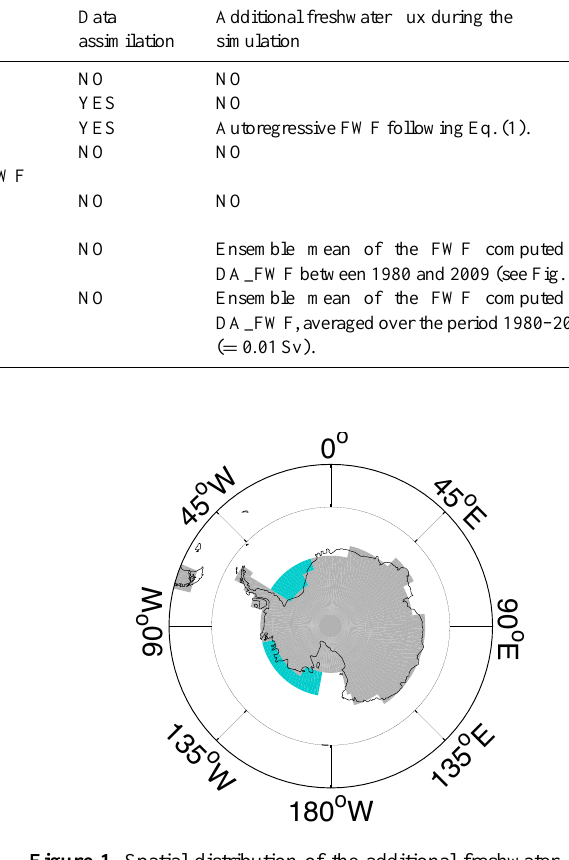
Figure 1. Spatial distribution of the additional freshwater flux in- cluded in model simulations (shaded blue). The shaded grey areas correspond to the land mask of the ocean